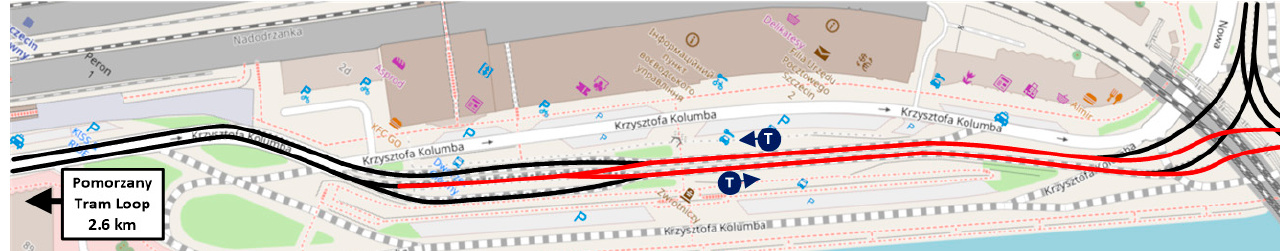
Figure 18. Application of bi-directional trams on tram line 13 using a switch-back terminal in front of the main railway station in Szczecin (own study based on openstreetmap.org).